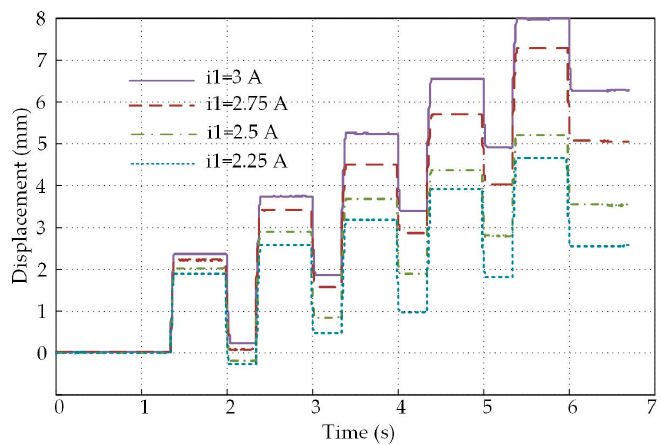
Figure 12. CR displacement vs. positive current amplitude.